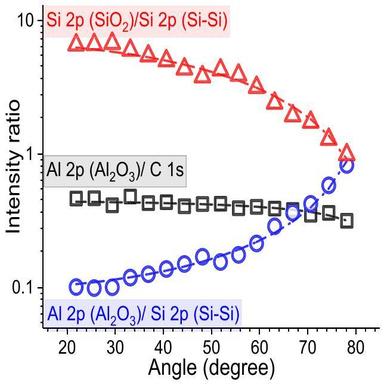
Non-destructive depth profile of the ultrathin Al2O3 sample with carbon contamination and native SiO2 layer. The pARXPS simulation values (dotted line) correspond well to the experimental values of the intensity ratio (symbols).